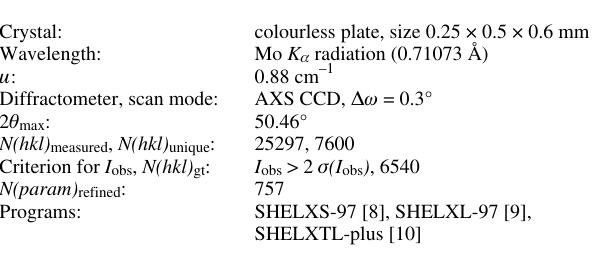
Table 1. Data collection and handling.